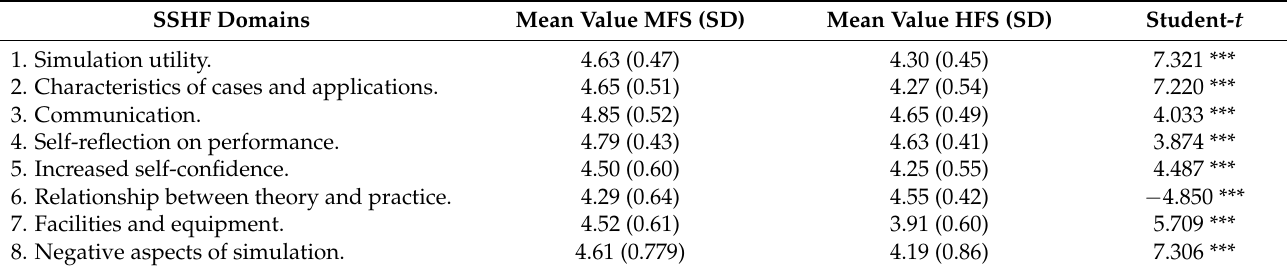
Table 1. Mean differences test of Satisfaction Scale Questionnaire with High-Fidelity Clinical Simulation (SSHF) domains by type of simulation (medium- and high-fidelity simulation (MFS and